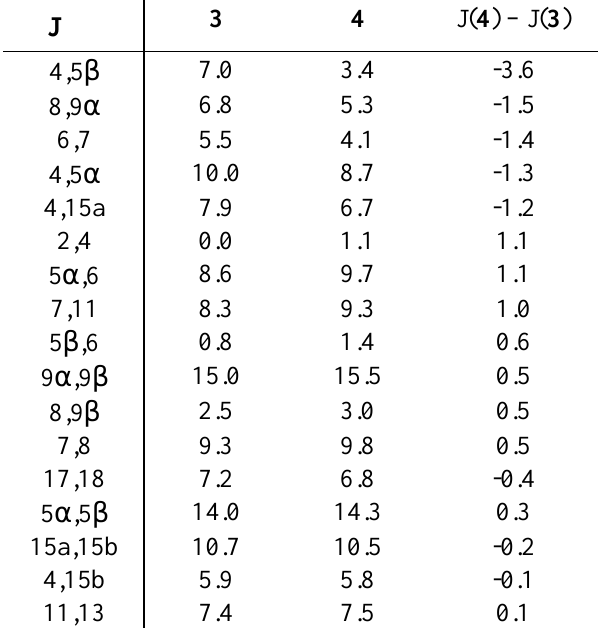
Table 2. 1 H NMR coupling constants (Hz) of isomers 3 and 4